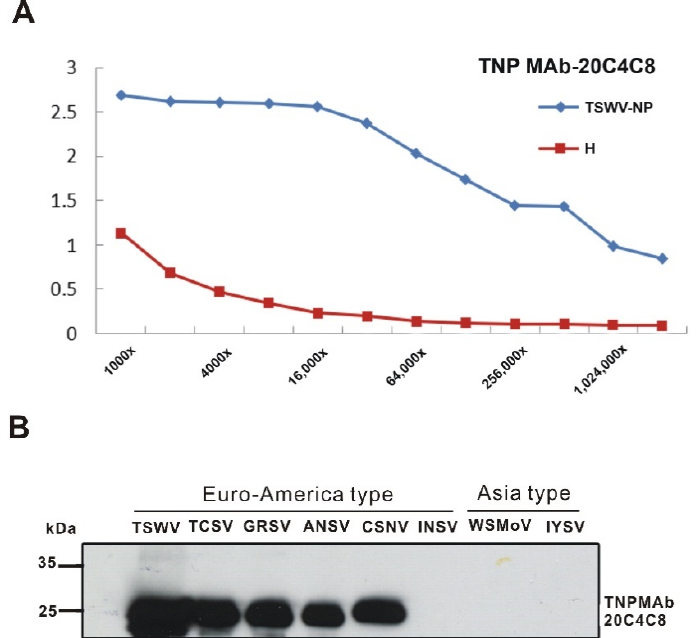
Figure 1. Characterization of the monoclonal antibody (MAb) 20C4C8 against the nucleocapsid protein (NP) of the tomato spotted wilt virus (TSWV), designated as TNP MAb. ( A ) Titration of the TSWV NP (TNP) MAb against the NP of TSWV. The TSWV-infected leaf tissue of a Nicotiana benthamiana plant 10 days after inoculation was used as the antigen source at four-fold dilution. H indicates the uninfected control. ( B ) Serological reactions of the TNP MAb with NPs of different orthotospoviruses. Detection of the NPs of orthotospoviruses by TNP MAb in western blotting. The Euro-American type orthotospoviruses used for the test included five TSWV serogroup members of TSWV, the tomato chlorotic spot virus (TCSV), the groundnut ringspot virus (GRSV), the alstroemeria necrotic streak virus (ANSV), the chrysanthemum stem necrosis virus (CSNV), and the impatiens necrotic spot virus (INSV) serotype. The Asia type orthotospoviruses tested were the watermelon silver mottle virus (WSMoV), the iris yellow spot virus (IYSV), and the type members of WSMoV and INSV serogroups,